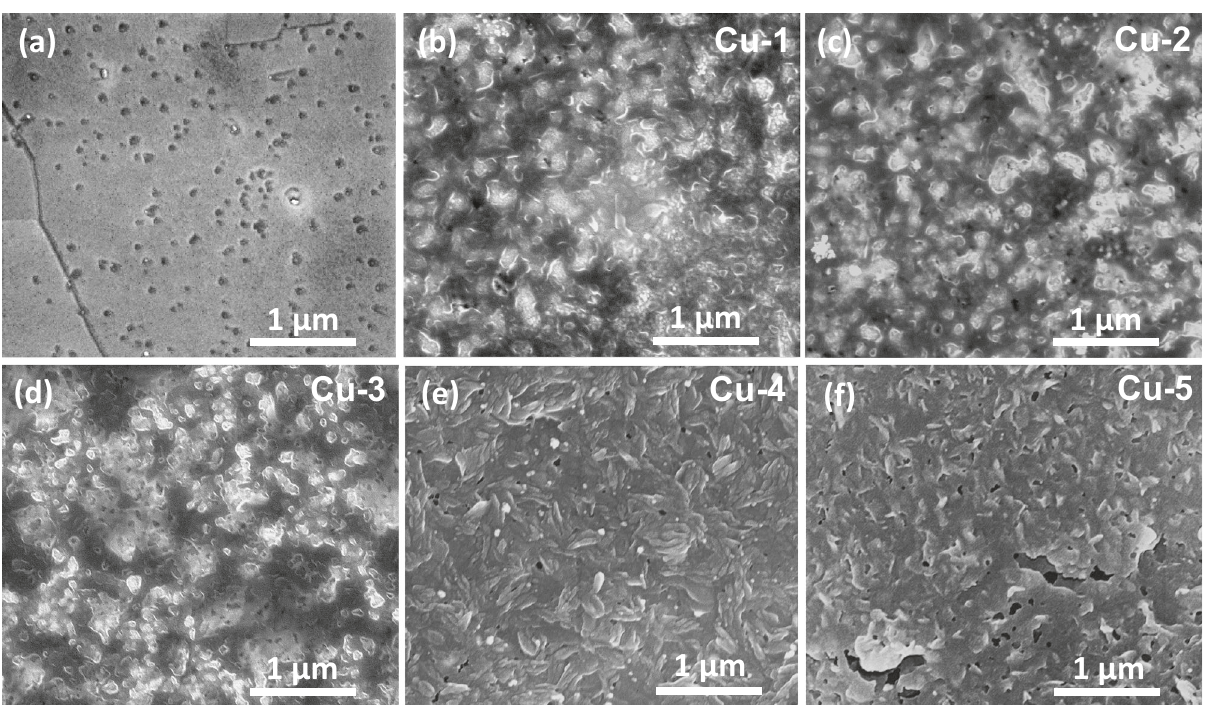
Fig. 2 | SEM images. a pristine Cu and b − f T-bipyridine modi fi ed Cu-n (n=1 − 5) electrodes prior to electrolysis.